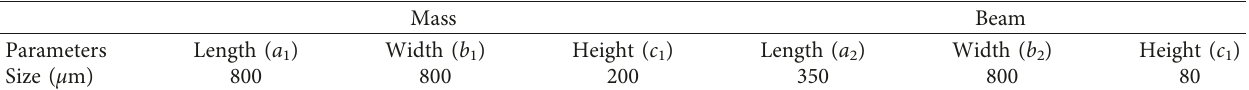
Table 1: Structural parameters of the High-G MEMS